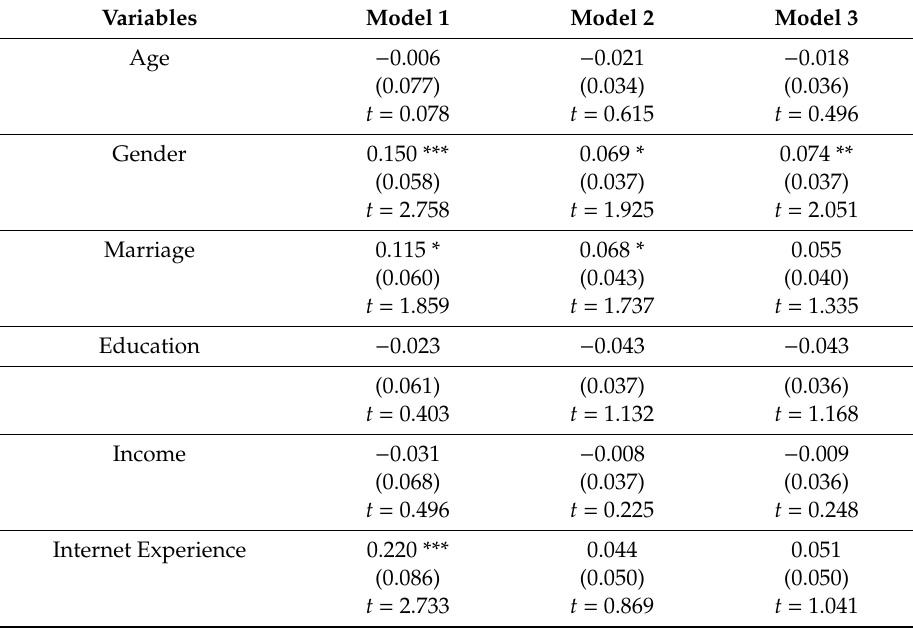
Table 6. Partial Least Squares (PLS)